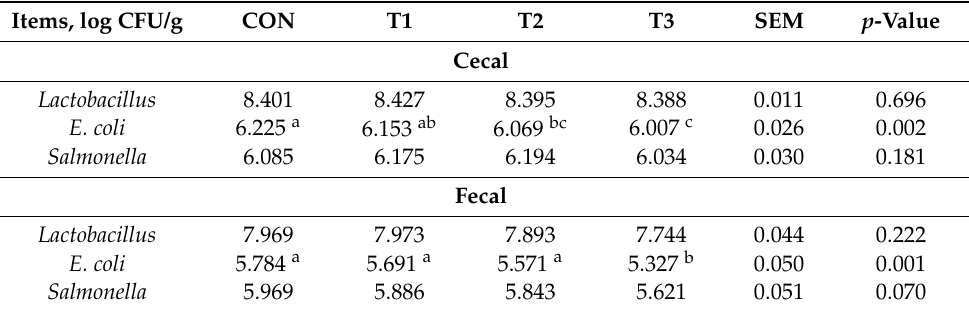
Table 10. Effects of full-fat almonds on bacteria counts in the cecal-fecal in broiler chickens. Items, log CFU/g CON T1 T2 T3 SEM p -Value Cecal